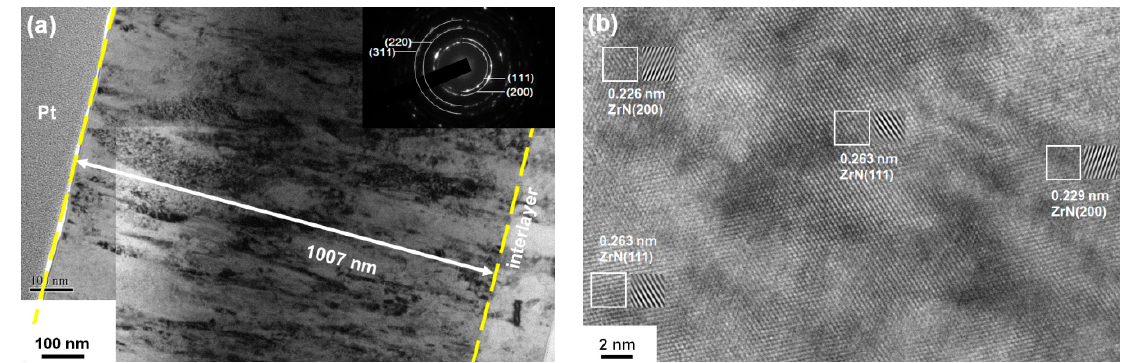
Figure 7. ( a ) Cross-sectional transmission electron microscopy (TEM) image and selected area electron di ff raction (SAED) pattern and ( b ) high-resolution TEM image of the Zr 62.3 Si 1.4 N 36.3 films (batch